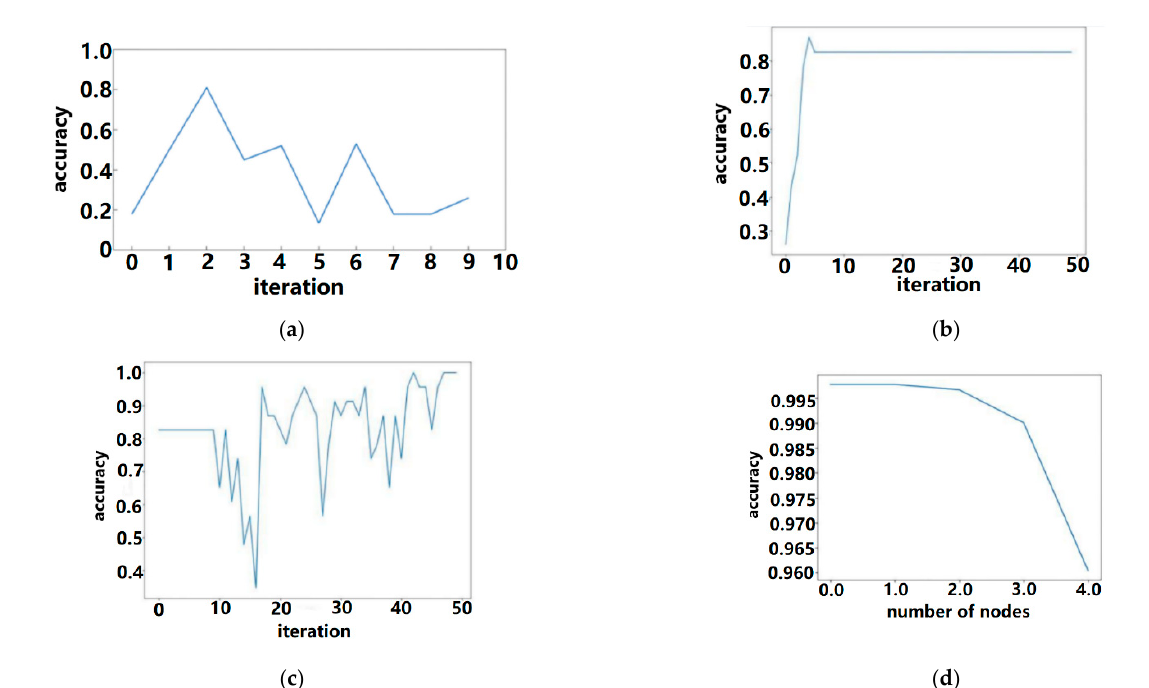
Figure 6. Line chart of model accuracy variation with number of iterations. ( a ) Line chart of ResNet accuracy variation with number of iterations; ( b ) line chart of VGG19 accuracy variation with number of iterations; ( c ) line chart of AlexNet accuracy variation with number of iterations; ( d ) line chart of CBNLM ‐ BLS accuracy variation with number of nodes.